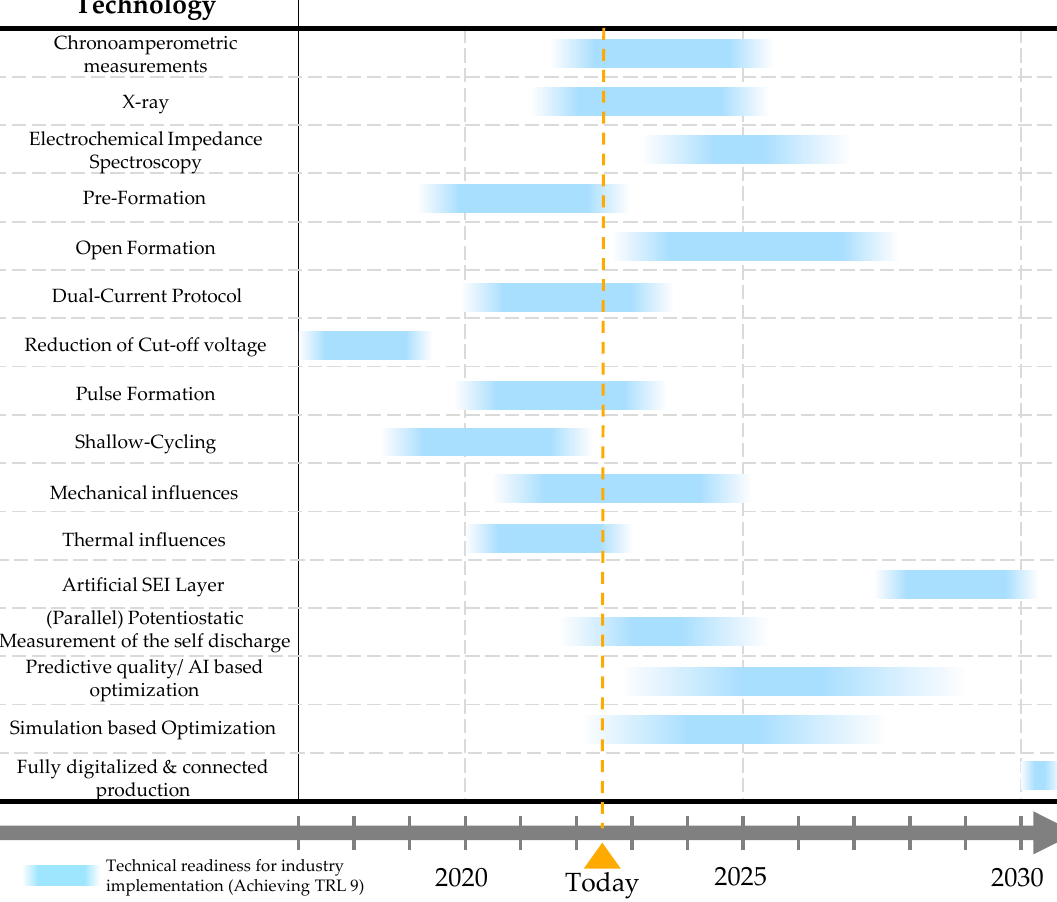
Figure 11. Overview of the technology roadmap in cell finishing .